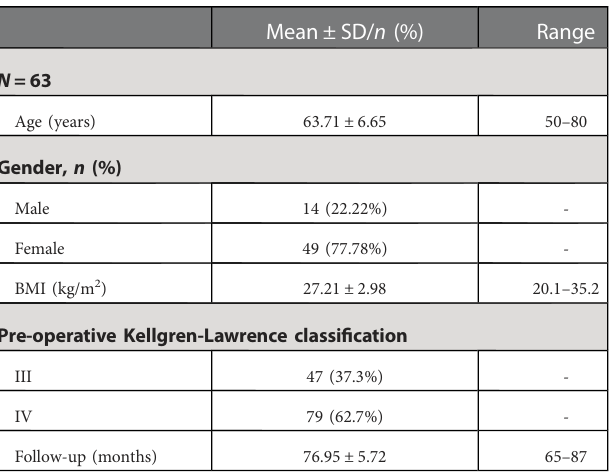
TABLE 1 Demographic characteristics.